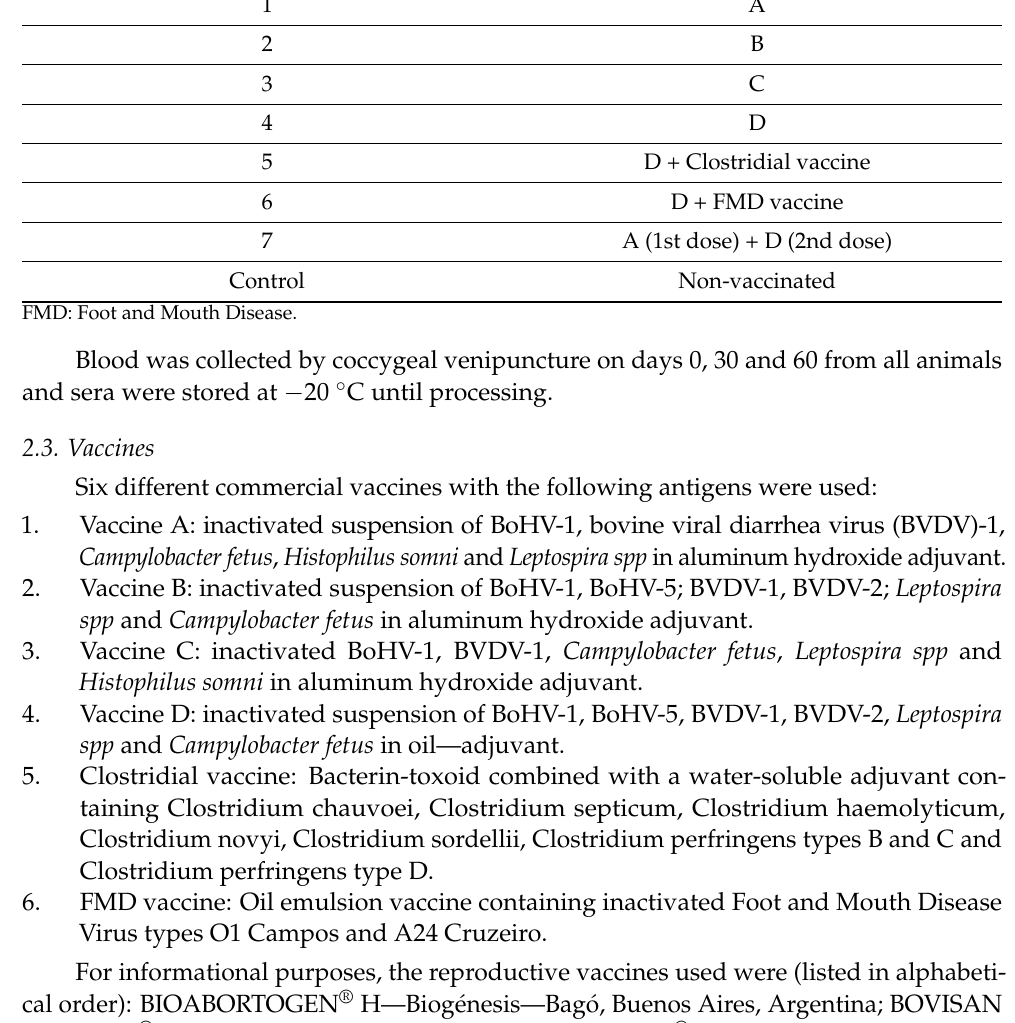
Table 1. Groups of animals ( n = 15) and vaccines used in this study. Groups Vaccines 1 A 2